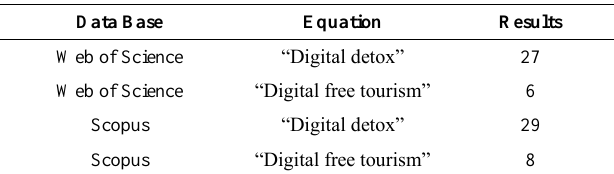
Table 1. Frequency of related